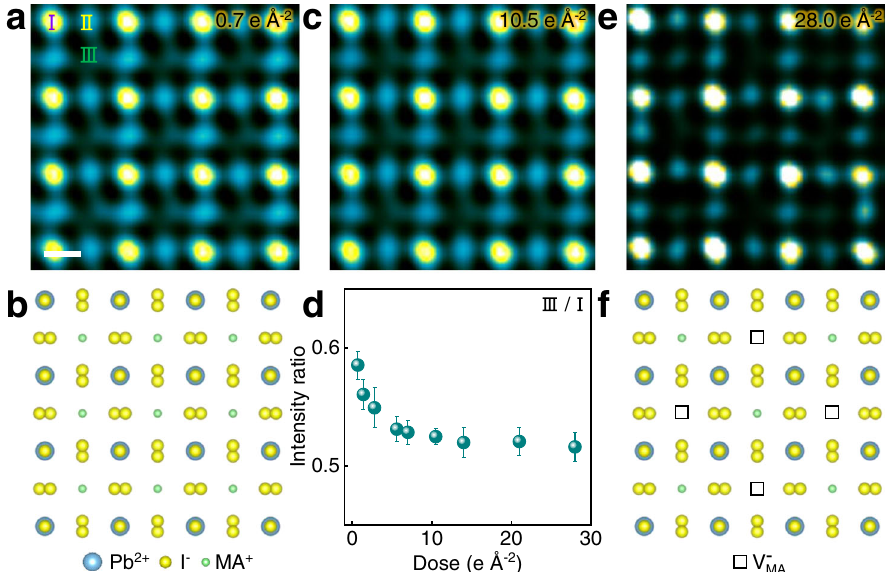
Fig. 2 Atomic-imaging of the loss of MA + and intermediate phase. a HRTEM image acquired at 0.7e Å − 2 . ‘ I ’ , ‘ II ’ and ‘ III ’ columns correspond to Pb 2 + -I − , I − , and MA + columns respectively. Scale bar, 3Å. b Structural model of tetragonal MAPbI 3 . c HRTEM image acquired at 10.5e Å − 2 . d Intensity ratio of ‘ III ’ to ‘ I ’ column with increased doses. Nine data points of ‘ III ’ and ‘ I ’ type columns are used to obtain nine intensity ratios at each dose. The error bars represent standard deviations. e HRTEM image acquired at 28.0e Å − 2 . f Structural model of MA 0.5 PbI 3 . The squares indicate V (cid:1)